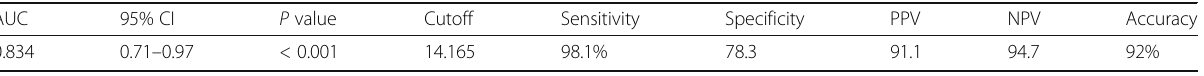
Fig. 7 (example of left lobe focal lesion): 55 years old male patient with chronic liver disease under follow up abdominal ultrasound. Imaging findings: grey scale B-mode ultrasonography ( a ): shrunken cirrhotic liver with a well-defined hyperechoic focal lesion seen in left lobe measuring 4.5 × 4.1 cm with 3.6 cm depth from the skin. ϖ Color-coded shear wave sono-elastography: the lesion ( b , c , d ) and parenchyma ( e , f , g ) showed variable colors in the three acquisitions. ϖ Shear wave sono-elastography stiffness values of the focal lesion: the lesion showed variable stiffness values in the three acquisitions. E1 = 18.59 kPa ( b ), E2 = 8.67 kPa ( c ), and E3 = 12.18 kPa ( d ). Calculated average stiffness value of the three acquisitions = 13.14 kPa. ϖ Shear wave sono-elastography stiffness values of the parenchyma: the parenchyma showed variable stiffness values in